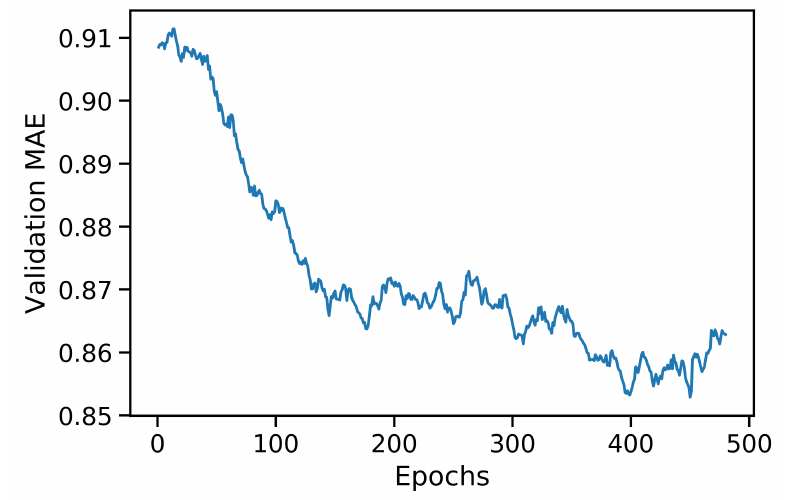
Figure 5. Mean absolute error (MAE) for every generation during the NN training